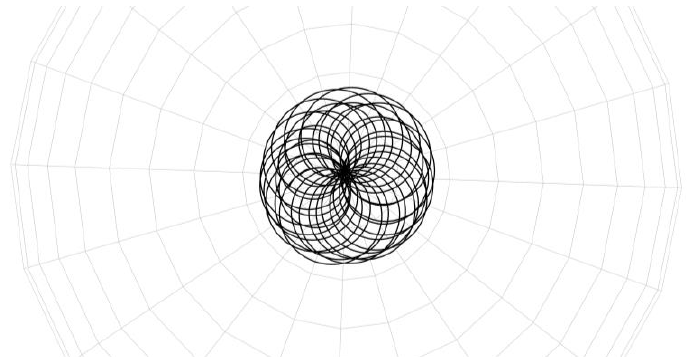
Figure 3. Top view of the spatial evolution of a circular SOP.